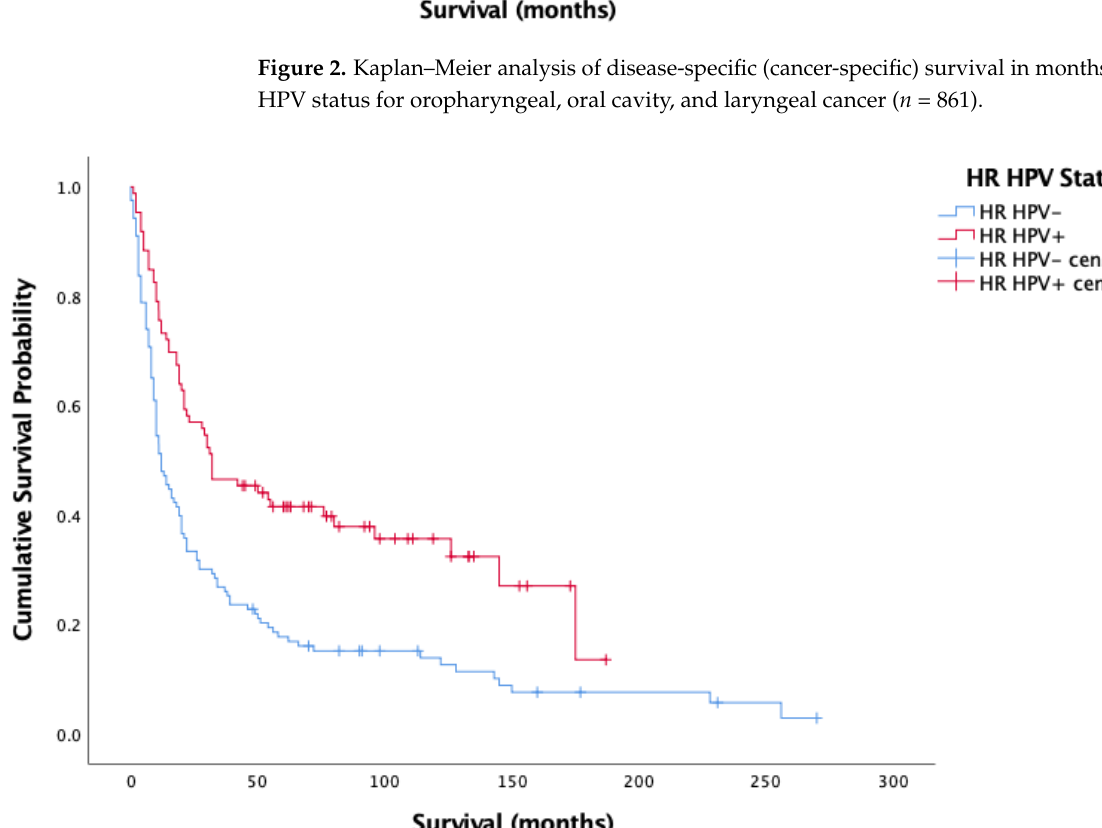
Figure 2. Kaplan – Meier analysis of disease-specific (cancer-specific) survival in months based on HR HPV status for oropharyngeal, oral cavity, and laryngeal cancer (n = 861).